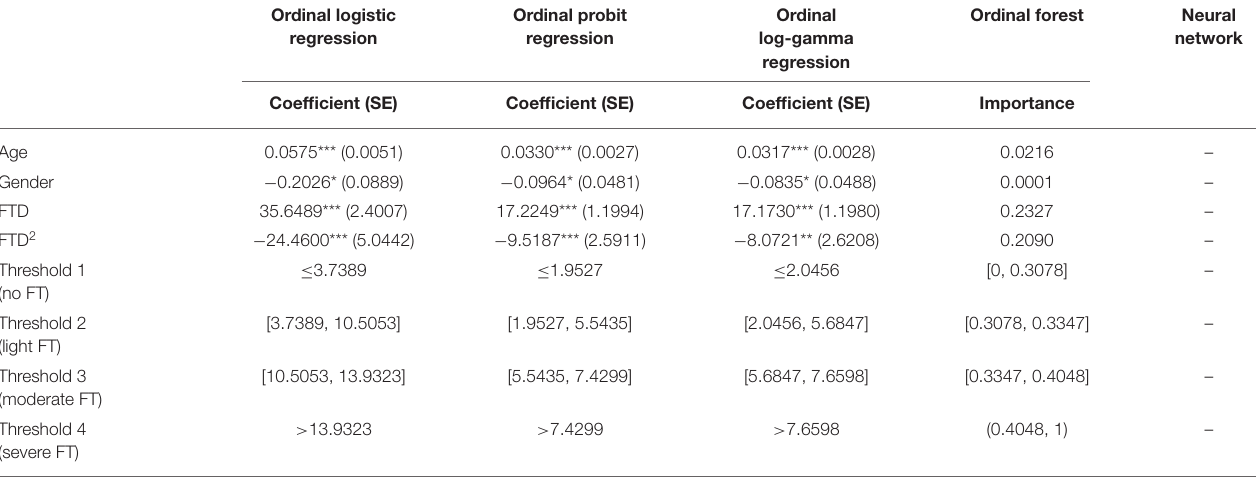
TABLE 2 | The results of different algorithms.